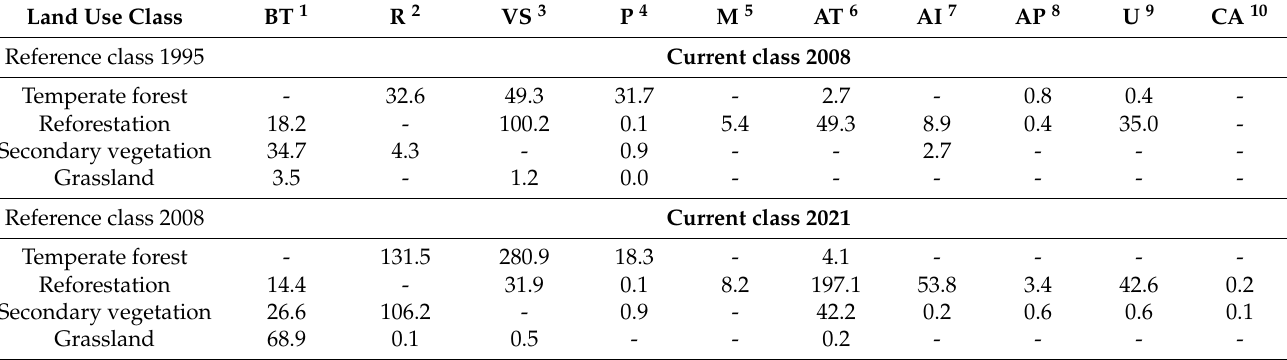
Table 5. Matrix of the dynamics of land use changes (hectares) from 1995 to 2008 and from 2008 to